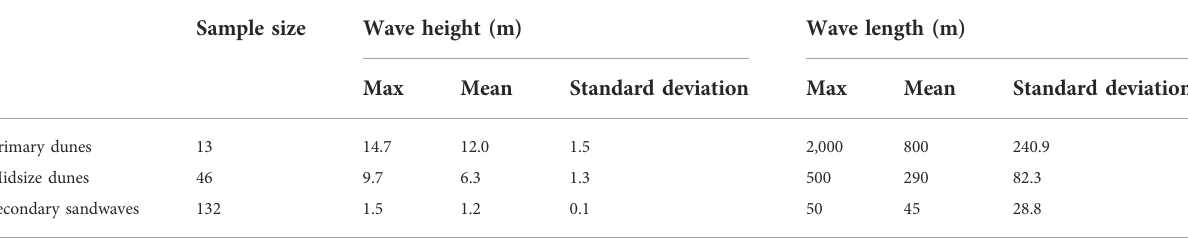
TABLE 1 The statistics of the sandwave